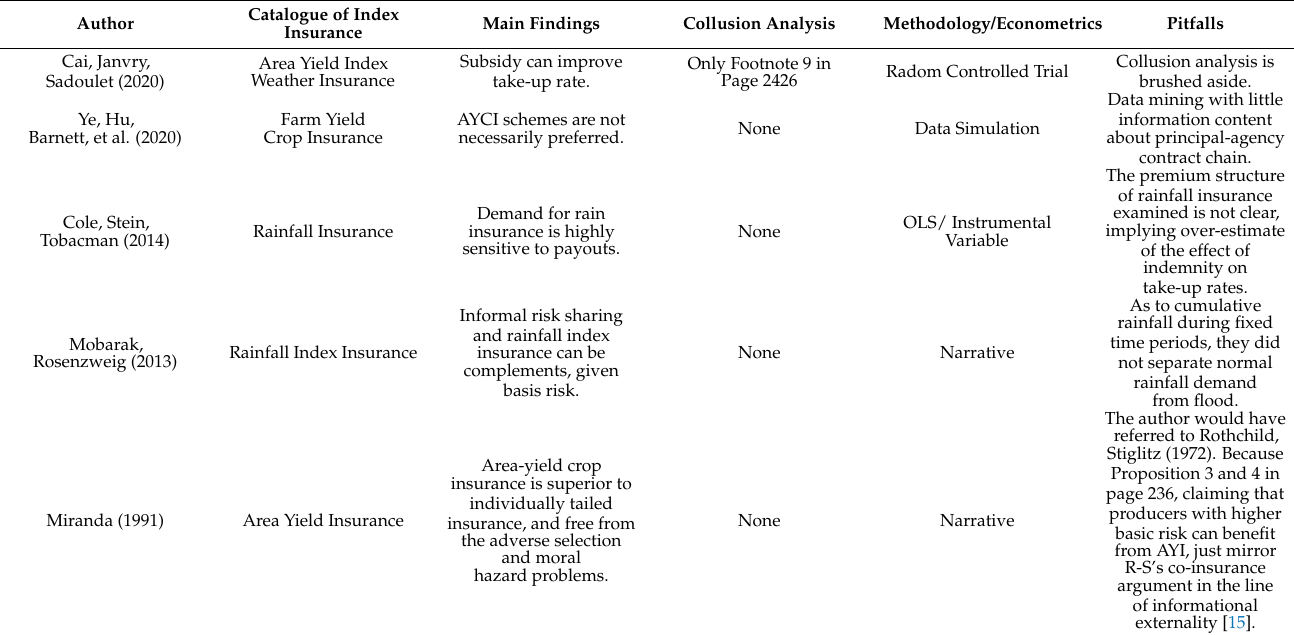
Table 1. Indexed-based Agricultural